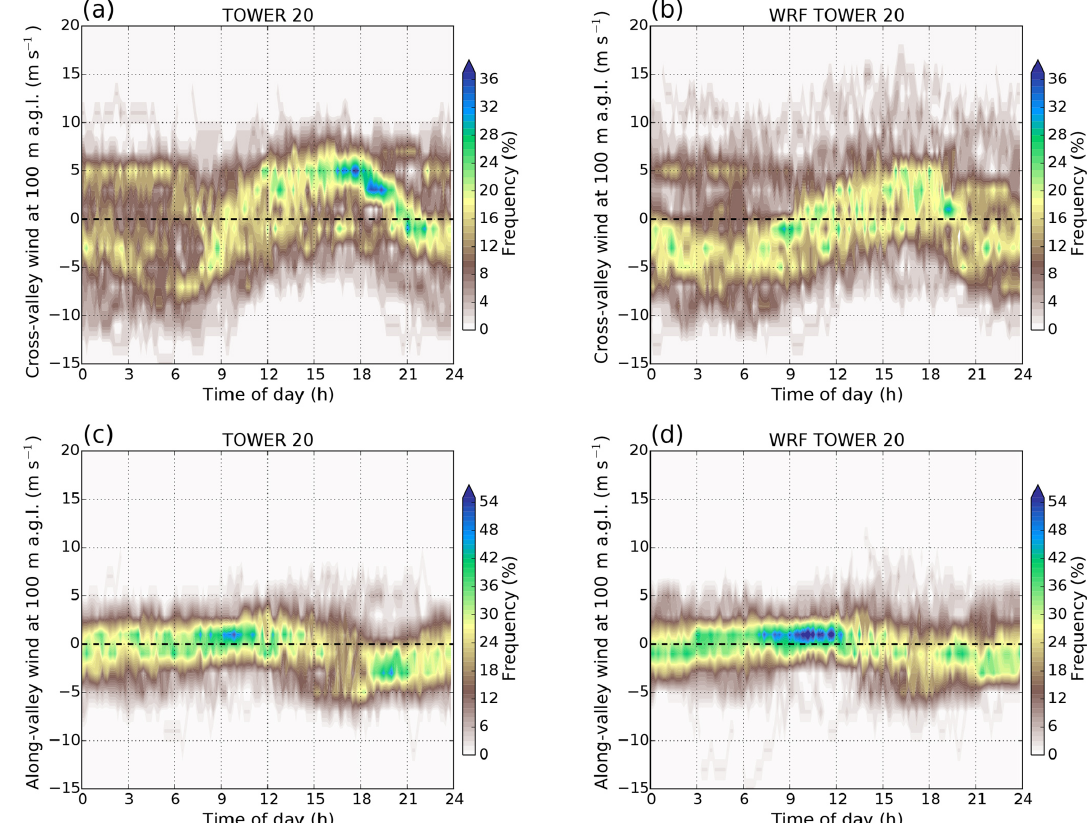
Figure 8. Diurnal distribution of (a, b) cross- and (c, d) along-valley winds at 100ma.g.l. at tower T20 in the period 1 May to 15 June 2017. Shown are observed tower data in panels (a) and (c) and data from WRF D3 simulations in panels (b) and (d)